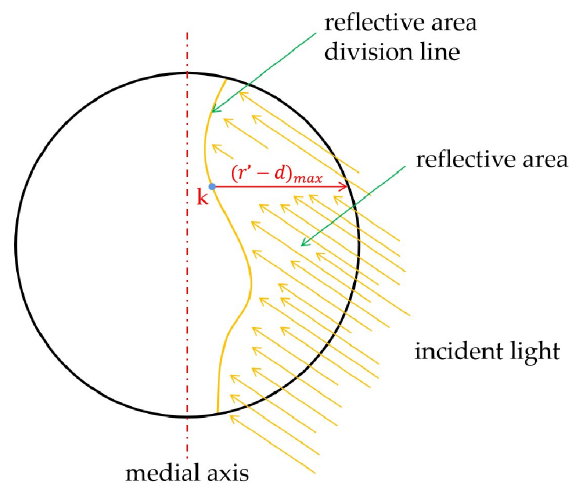
Figure 15. Reflective area